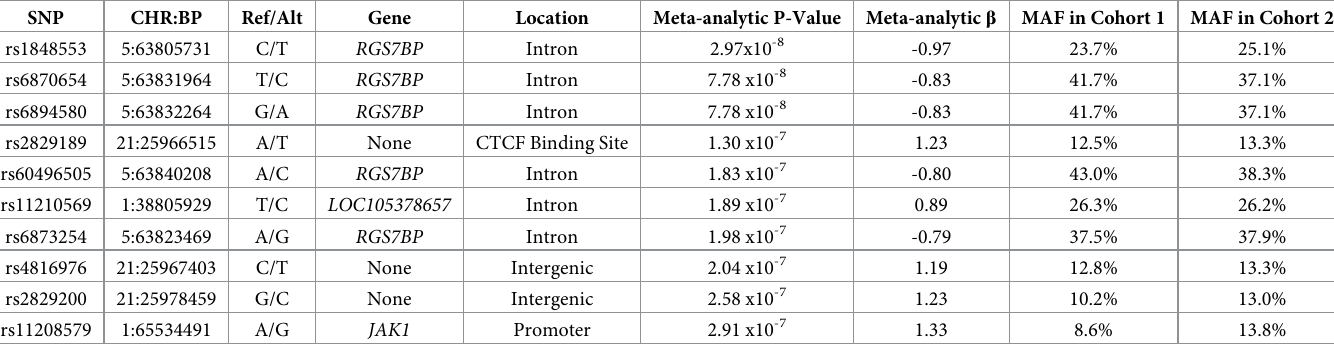
Table 2. Annotation for Top 10 SNPs for Association with TBscore, Sorted by P-Value. SNP CHR:BP